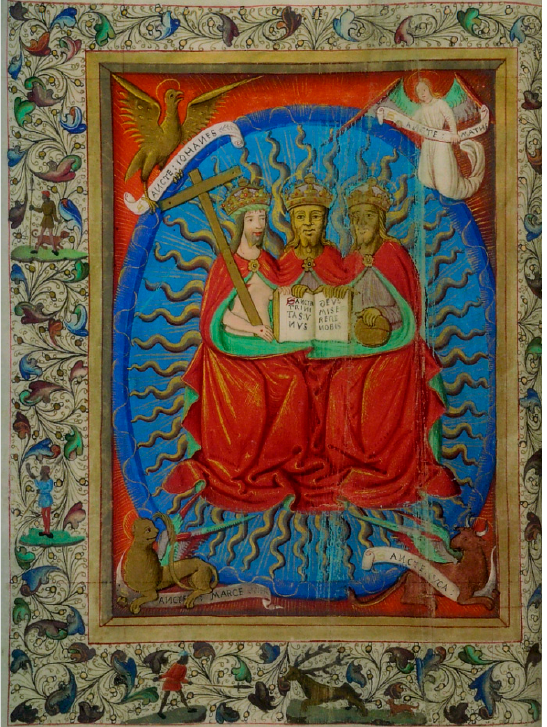
Figure 15. Holy Trinity, the Hours of Thomas Butler, f.9v, © British Library Board.